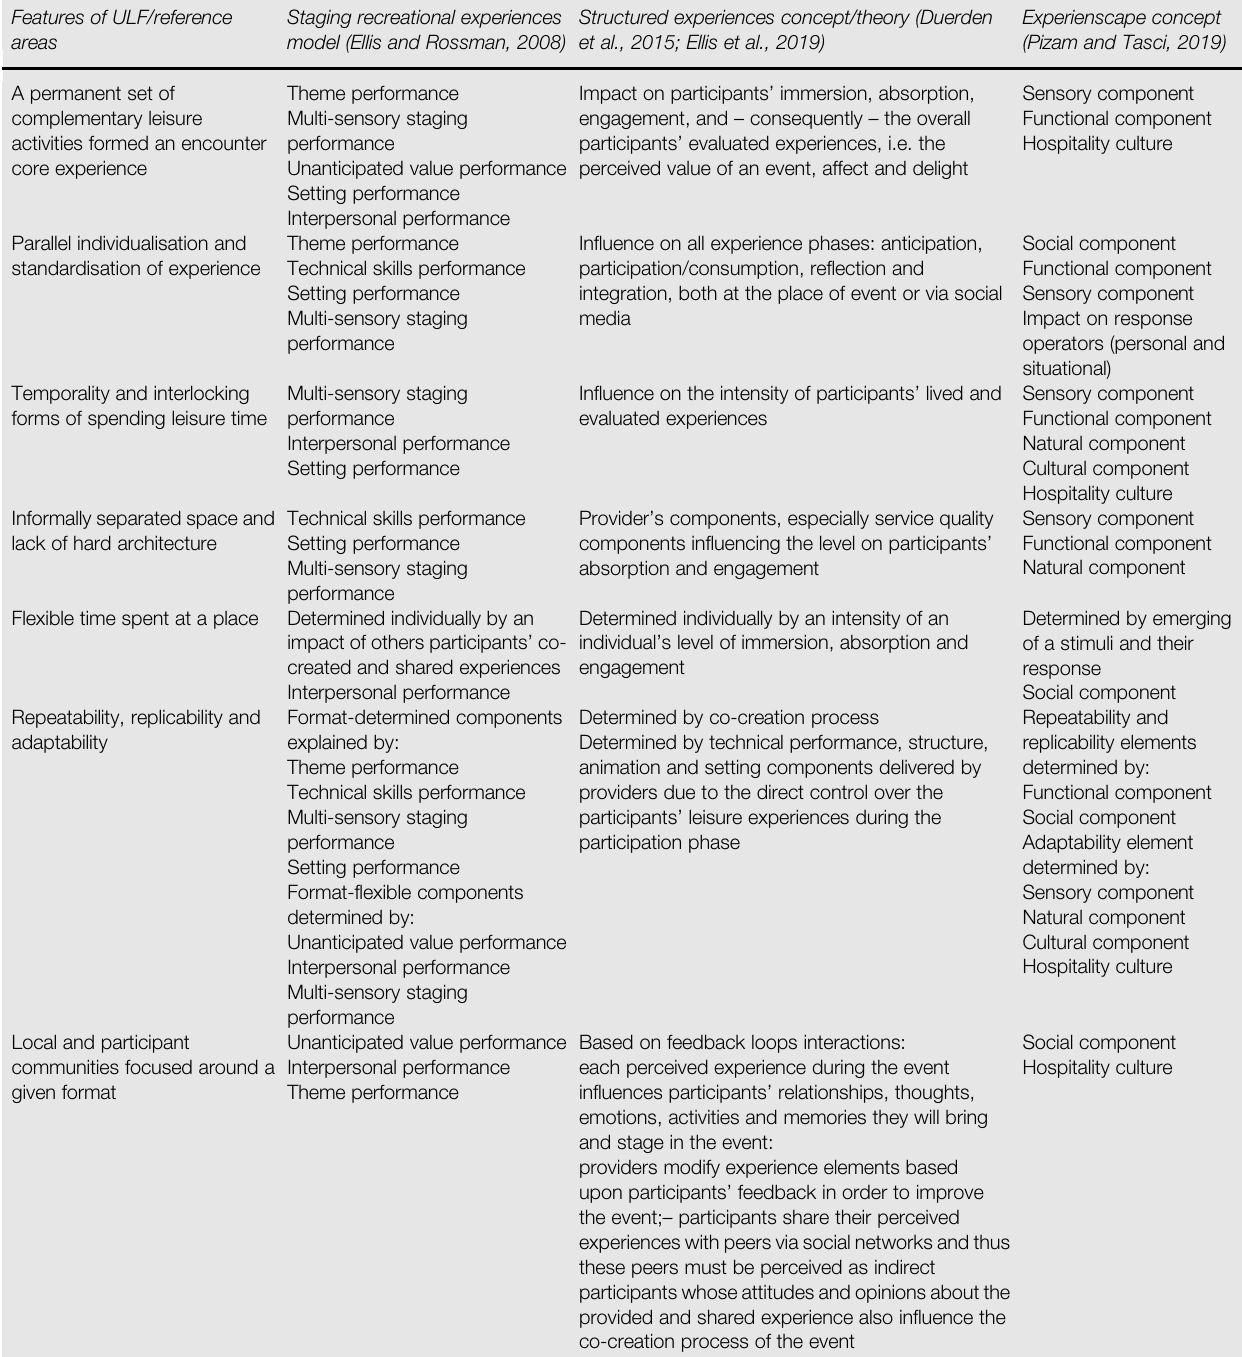
Table II Reference areas of urban leisure format concept to the SRE model, the SE theoretical concept and the experienscape